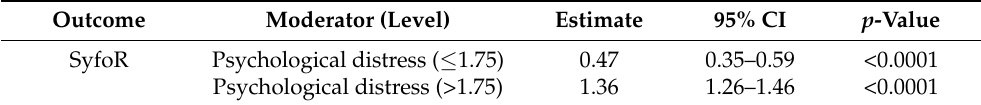
Table 4. Moderation of the association between endorsement of COVID-19 conspiracy theories and SyfoR by psychological distress.